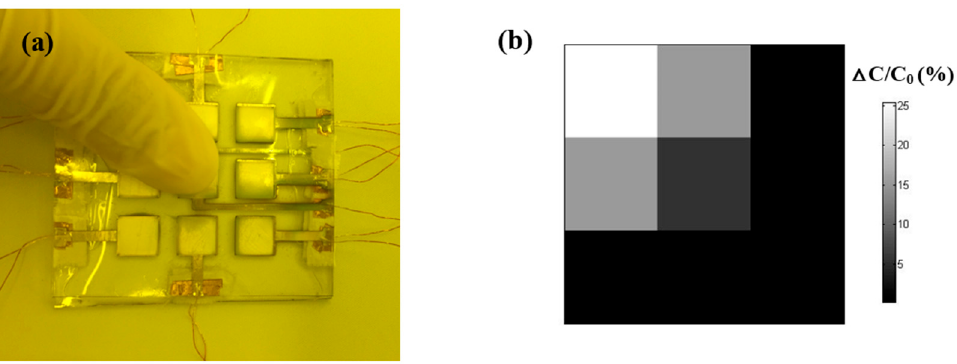
Figure 5. ( a ) Digital image of the fingers on the surface of the pressure sensor to test the finger pressure-sensing capability; ( b ) Finger pressure distribution presented by capacitance variation of every detecting unit.